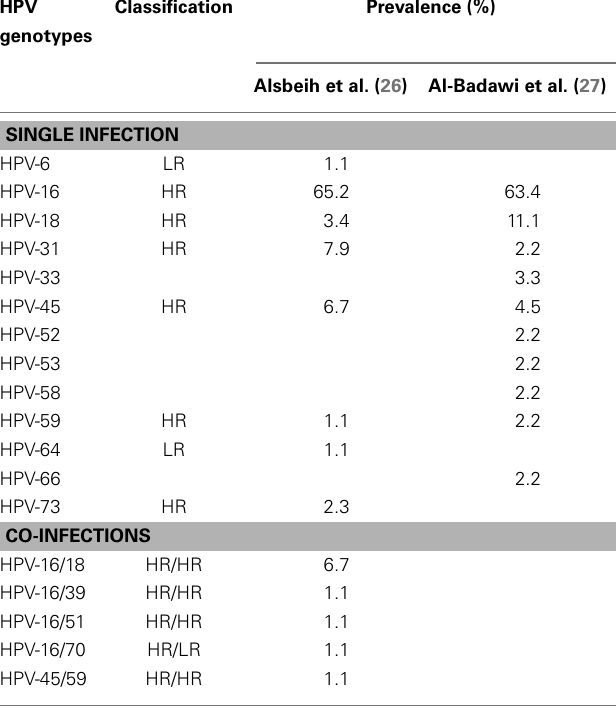
Table 1 | Prevalence of different HPV genotypes in two studies including 190 (92% HPV positive) cervical cancer patients in Saudi